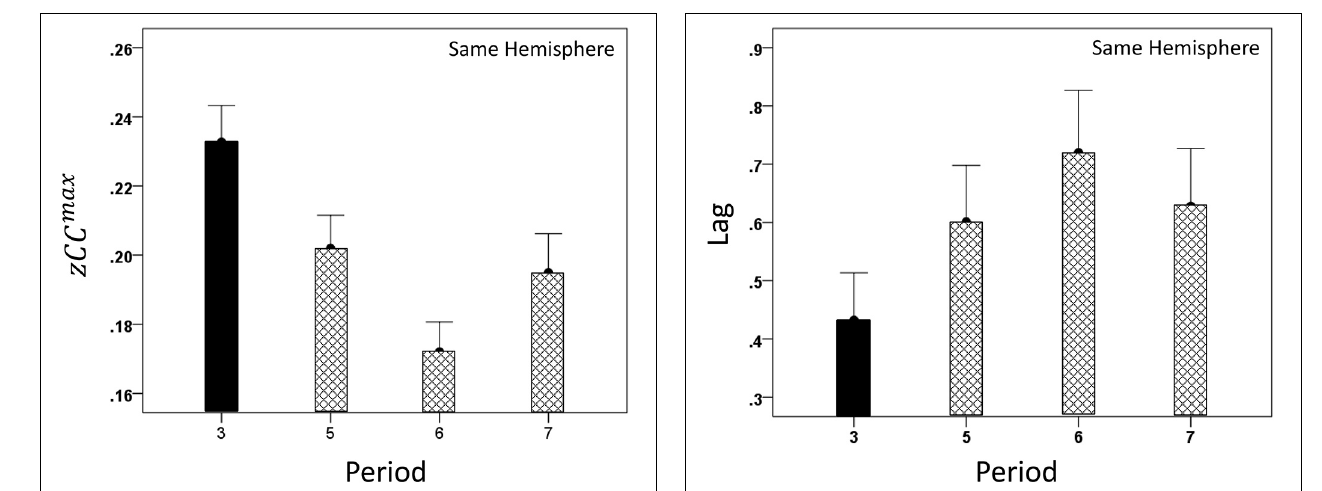
FIGURE 14 | Modulation of same-hemisphere CC max lag during task periods, being shortest at period 3 (see text for details).